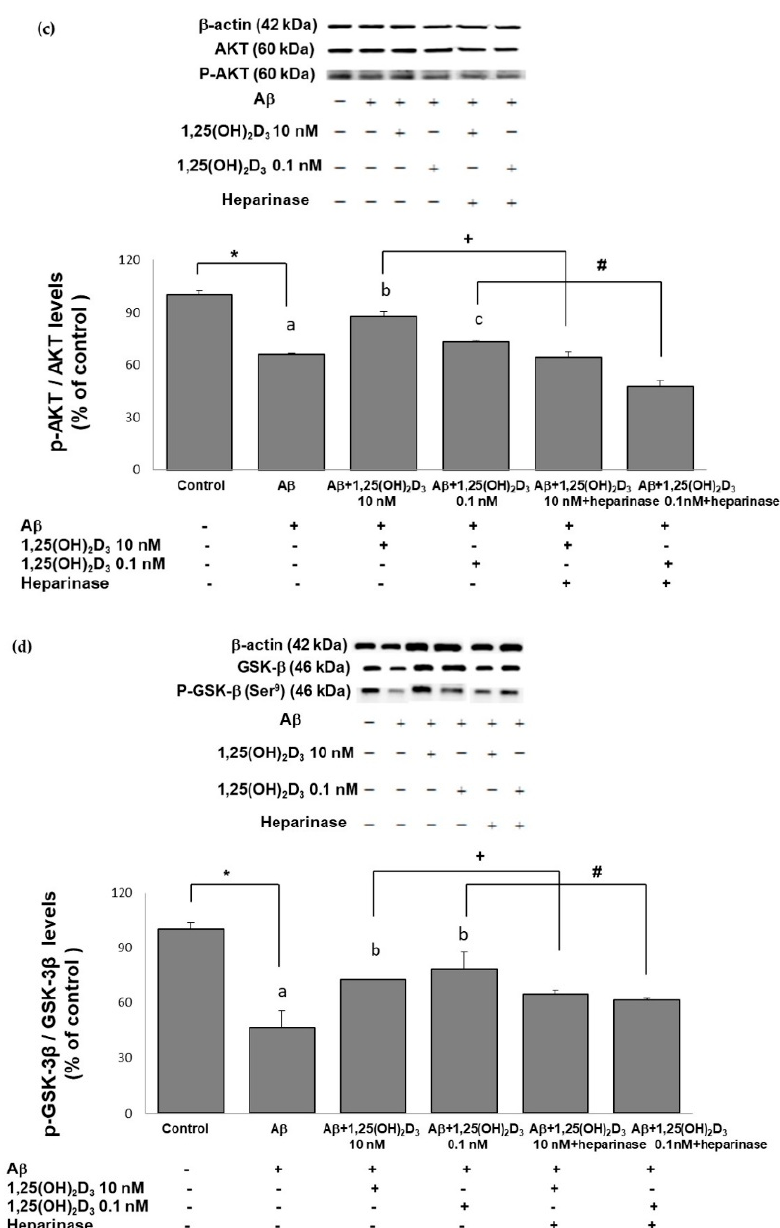
Figure 5. Effects of 1,25(OH) 2 D 3 on A β -induced changes in the phosphorylated (p)-tau/tau ratio ( a ), phosphorylated (p)-phosphatidylinositol 3K (PI3K)/PI3K ratio ( b ), the phosphorylated (p)-Akt/Akt ratio ( c ), and the phosphorylated (p)-glycogen synthase kinase (GSK)-3 β (Ser 9 )/GSK-3 β ratio ( d ) of protein expressions. SH-SY5Y cells were incubated with 1 μ M A β (25-35) prior to the addition of 0.1 and 10 nM 1,25(OH) 2 D 3 with or without heparinase III for 24 h. Data are presented as the mean ± SD of three experiments, and each experiment included triplicate repeats. * ,+,# Significantly differs between the two groups (statistical analysis was performed using Student’s t test). Bars of A β , A β + 0.1 nM 1,25(OH) 2 D 3 , and A β + 10 nM 1,25(OH) 2 D 3 with different letters significantly differ ( p < 0.05) (statistical analysis was performed using one-way analysis of variance (ANOVA) with Duncan’s post- hoc analysis).